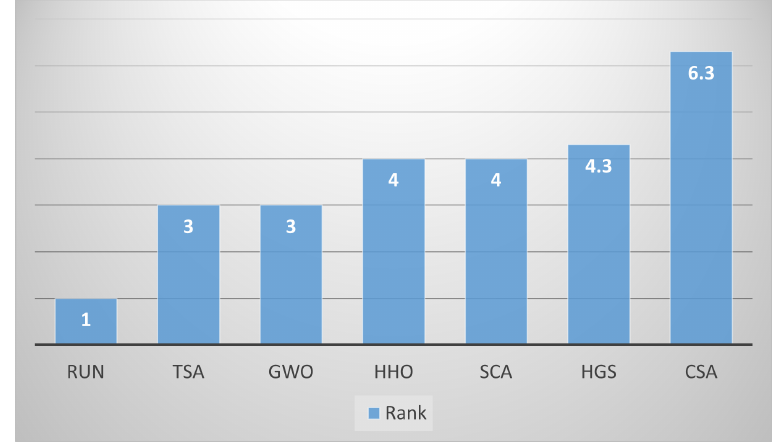
Figure 16. Friedman rank curve for SDSCM.